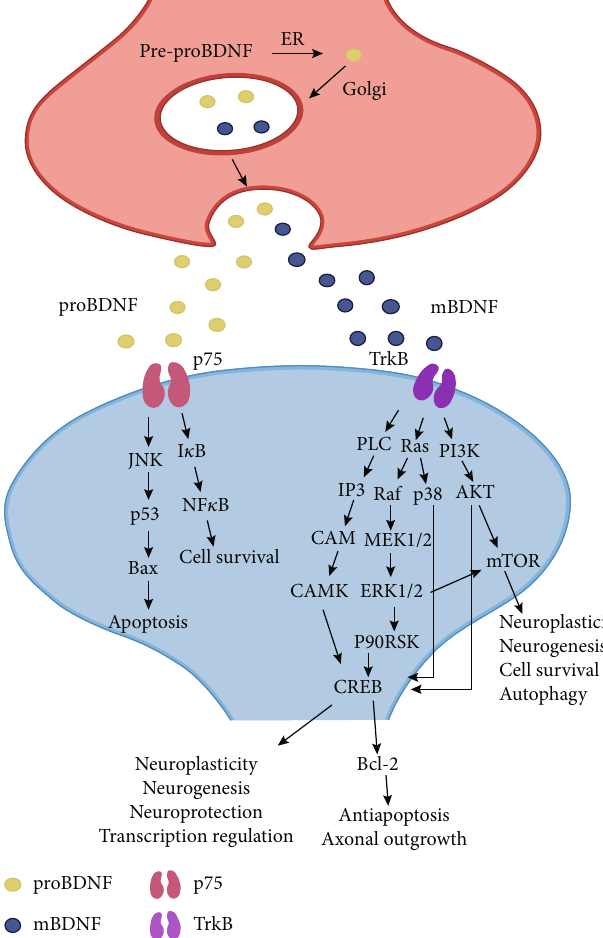
Figure 1: Diagrams of the BDNF-relevant signaling pathways. BDNF: brain-derived neurotrophic factor; ER: endoplasmic reticulum; TrkB: tropomyosin receptor kinase B; PLC: phospholipase C; IP3: inositol triphosphate; CAM: calmodulin; CAMK: CAM-dependent protein kinase; p90RSK: 90 kDa ribosomal S6 kinase; ERK1/2: extracellular-regulated kinase 1/2; PI3K: phosphoinositide 3-kinase; AKT: protein kinase B; mTOR: mammalian target of rapamycin; CREB: cAMP-response element binding protein; JNK: c-Jun N-terminal kinase; Bax: Bcl-2-associated X protein ; NF- κ B: nuclear factor- κ B; I κ B: an inhibitor of NF- κ